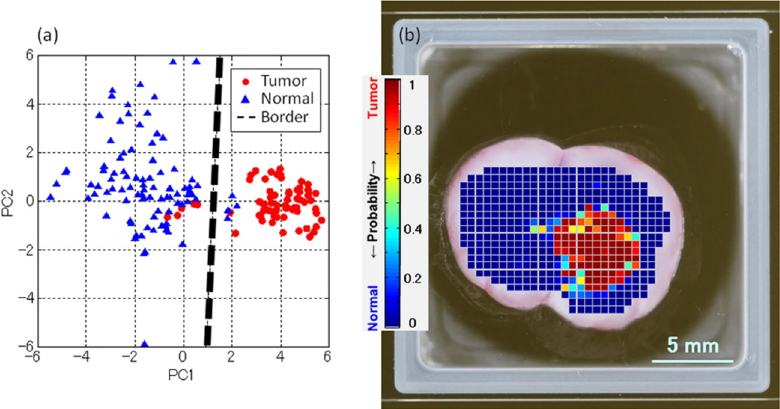
Figure 20. The score plot of the principal component analysis (PCA) results is presented for PC1 and PC2. The red circular and blue triangular points are the calculation results for the tumor and normal regions, respectively. The black dashed line shows the boundary between the normal and tumor regions ( a ). A color THz image shows the results of PCA discrimination ( b ). Adapted from [156].